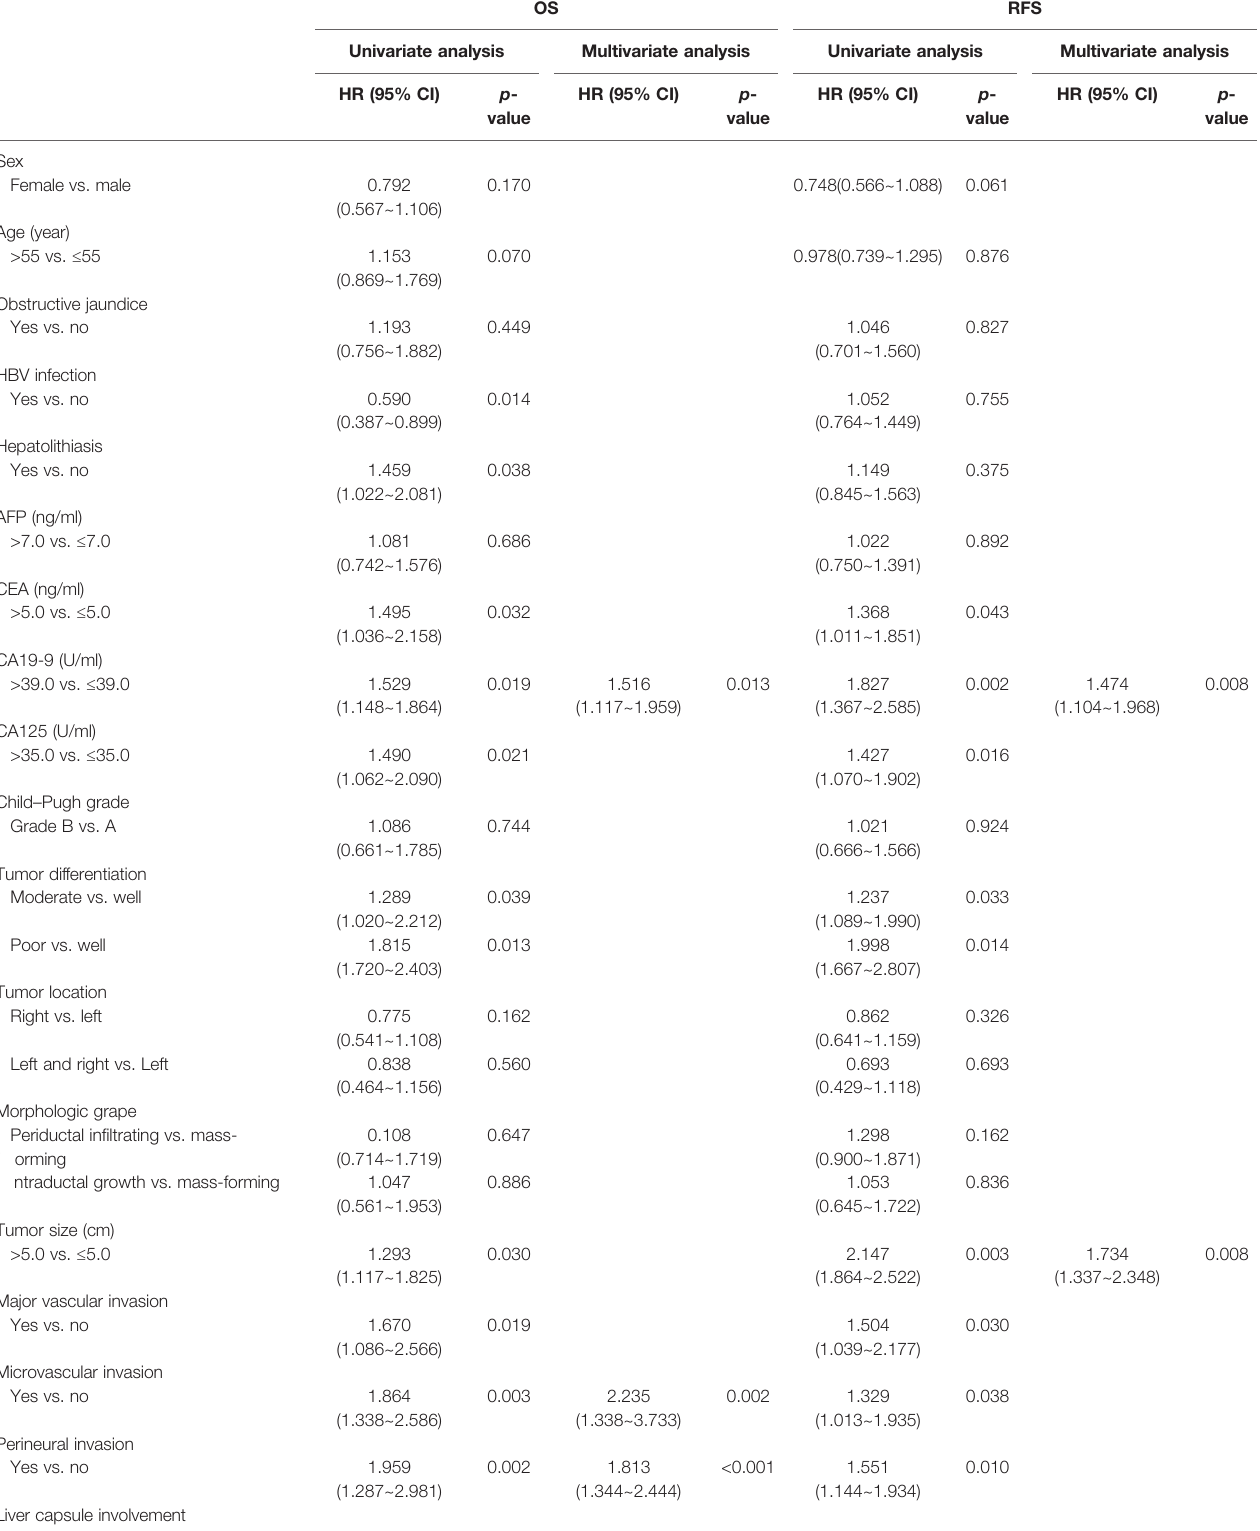
TABLE 1 | Univariate and multivariate analyses of prognosis for ICC after radical